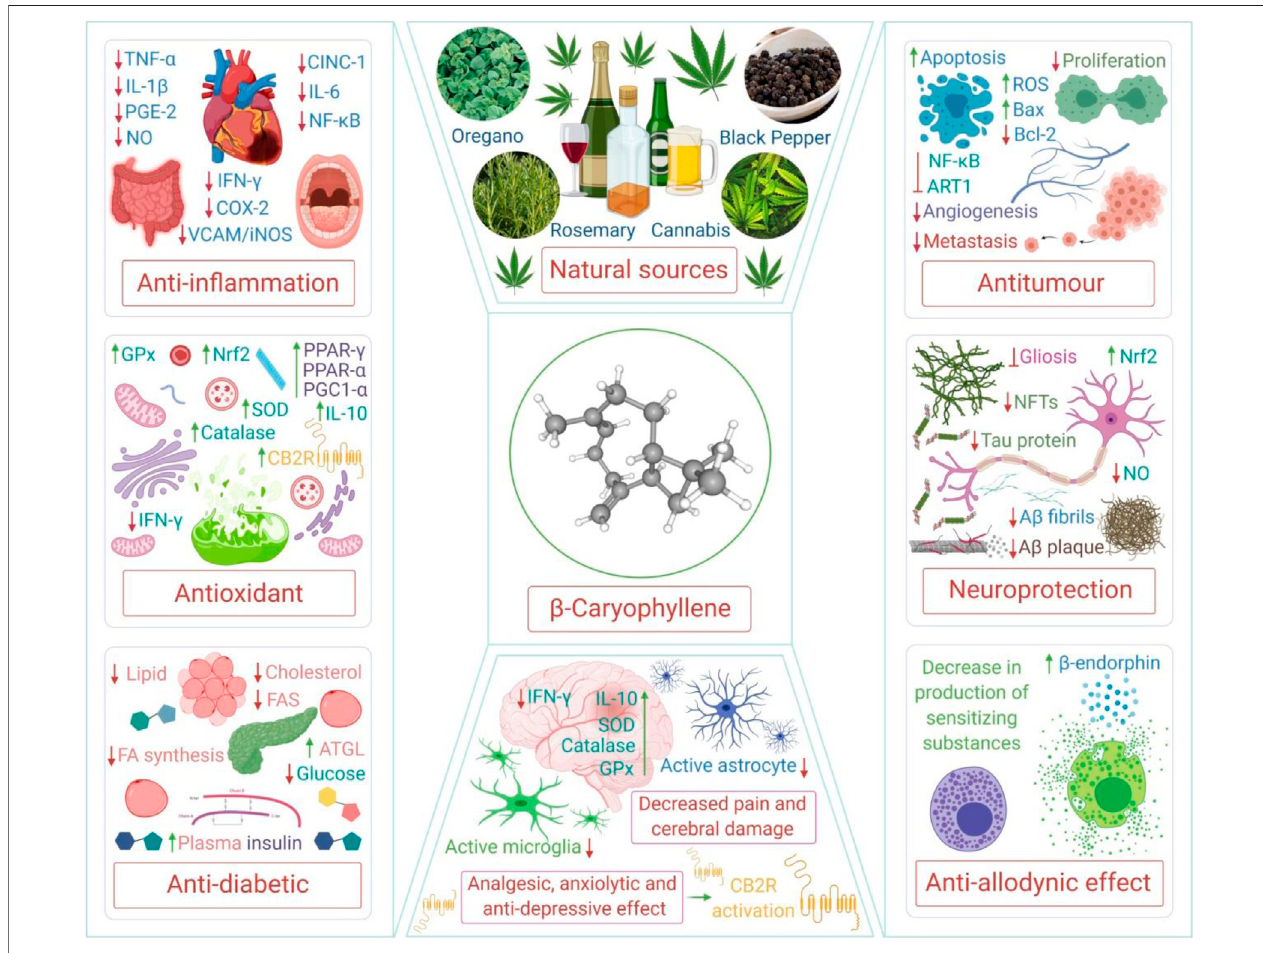
FIGURE1| ThestructureandvariouspolypharmacologicalpropertiesandtherapeuticpotentialofBCP.TNF- α ,tumornecrosisfactoralpha;IL,interleukin;PGE-2, prostaglandin E2; NO, nitric oxide; CINC-1, cytokine-induced neutrophil chemoattractant 1; NF- κ B, nuclear factor kappa B; IFN- γ , interferon gamma; COX-2, cyclooxygenase-2; VCAM, vascular cell adhesion protein; iNOS, inducible nitric oxide synthase; GPx, glutathione peroxidase; SOD, superoxide dismutase; PPAR- γ , peroxisomeproliferator-activated receptor gamma;PGC1- α ,peroxisomeproliferator-activatedreceptorgammacoactivator1-alpha;Nrf2,nuclearfactor erythroid 2 – relatedfactor2;FAS,fattyacidsynthase;ATGL,adiposetriglyceridelipase;ROS,reactiveoxygenspecies;Bax,Bcl-2associatedXprotein;Bcl-2,B-celllymphoma2; ART1, arginine ADP-ribosyltransferase 1; NFTs, neuro fi brillary tangles; A β , amyloid beta; CB2R, cannabinoid receptor type 2.